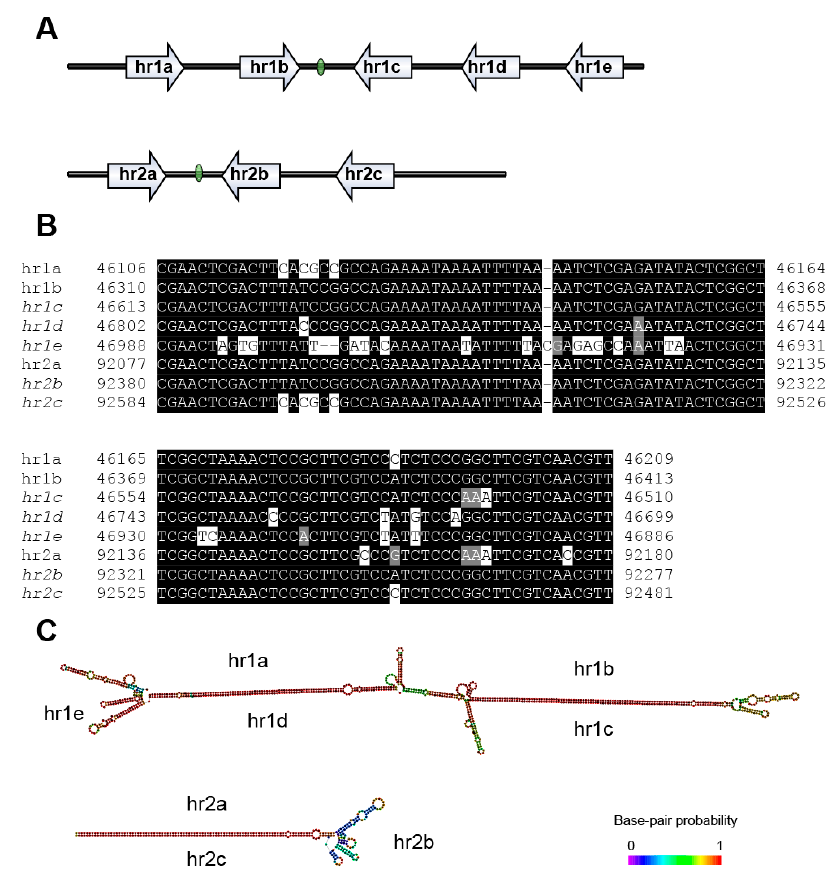
Figure 5. The structure and alignment of MaphGV homologous repeat regions ( hrs ). ( A ) The schematic diagram for the two hrs in the MaphGV genome. The blank arrows indicate the location and direction of the hr repeat units and the green bead-shaped region indicates the palindromic core. ( B ) Alignment of MaphGV hr repeat units. Nucleotide positions of the repeat units in the genome sequence are indicated at both ends of the aligned sequences. The name of the hr repeat units occurring on the reverse strand ( hr1c–e , hr2b–c ) is indicated in italics beside the alignment. The residues identical to the column-consensus ( > 50% identical) are shaded in black, whereas gray indicates nucleotides of the same class (containing either a purine or pyrimidine base). ( C ) Predicted secondary structures of MaphGV hrs . Secondary structures of single-strand hrs DNA were predicted using the ViennaRNA server. The base-pair probabilities of the predicted secondary structure are shown in color.